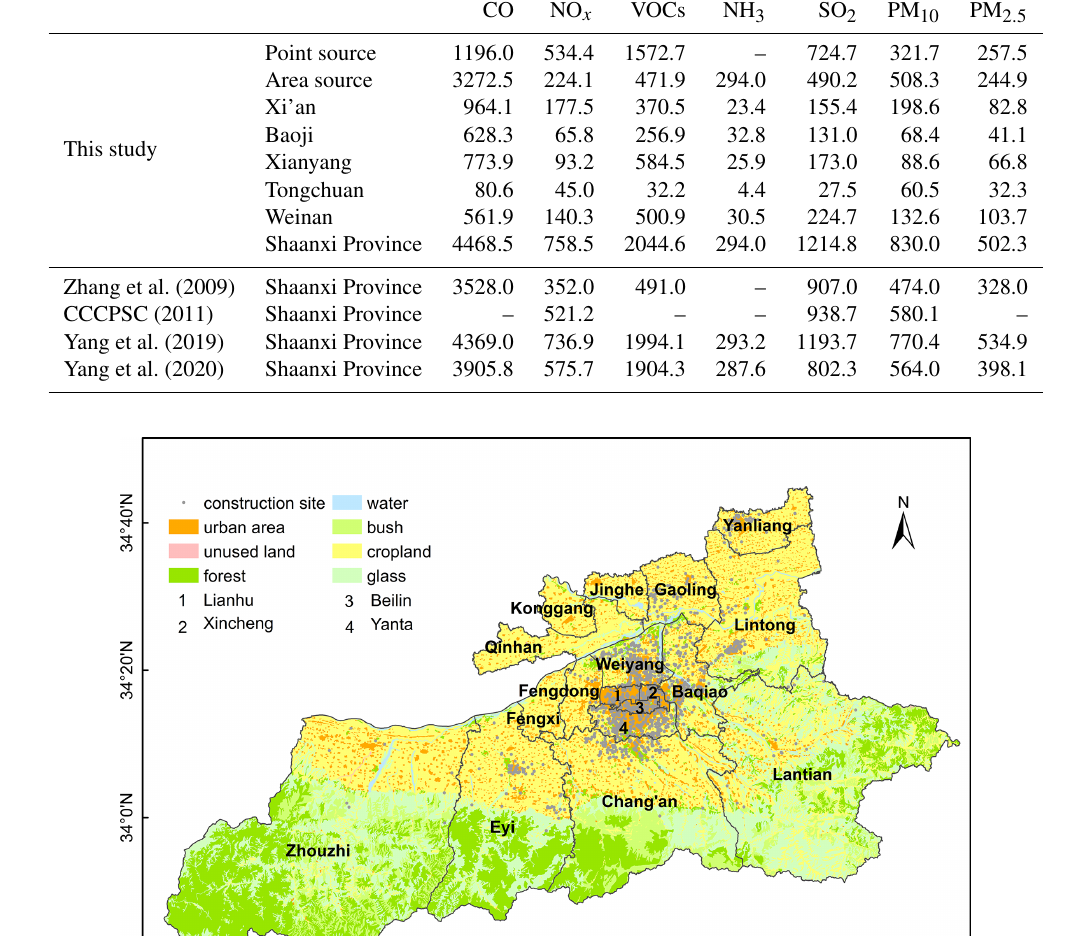
Table 2. Emission of major anthropogenic species in Shaanxi Province (unit: 10 3 tyr − 1 ).